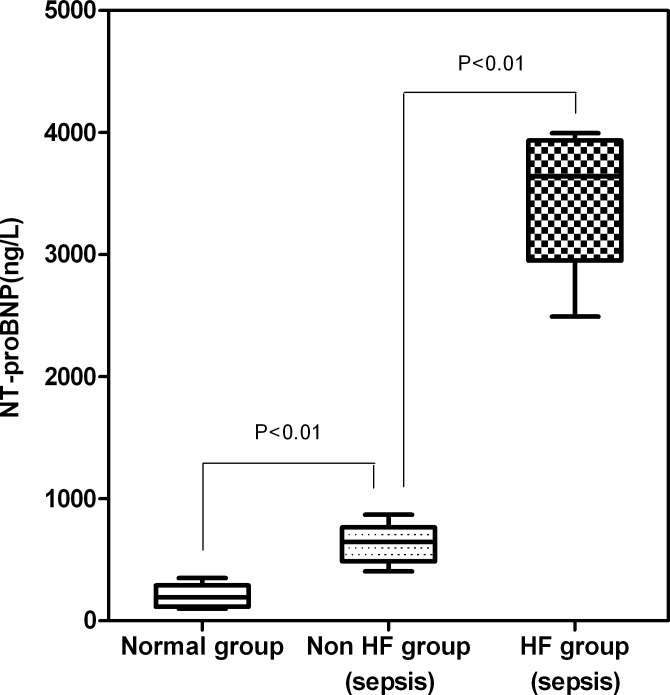
The median plasma NT-proBNP levels of the sepsis HF, sepsis non-HF, and healthy control groups were 3885 ng/L, 656 ng/Land 226 ng/L, respectively; the differences among them were significant (χ2 = 41.87, P < 0.001).